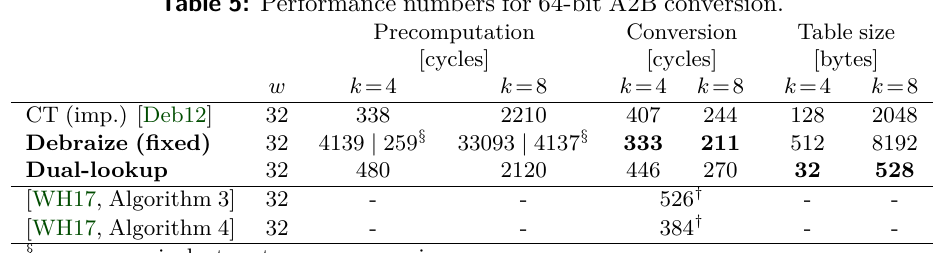
Simulated results using ARM Developer Suite v1.2, taken from [WH17, Table 4]. Randomness sampling is not included in the simulated